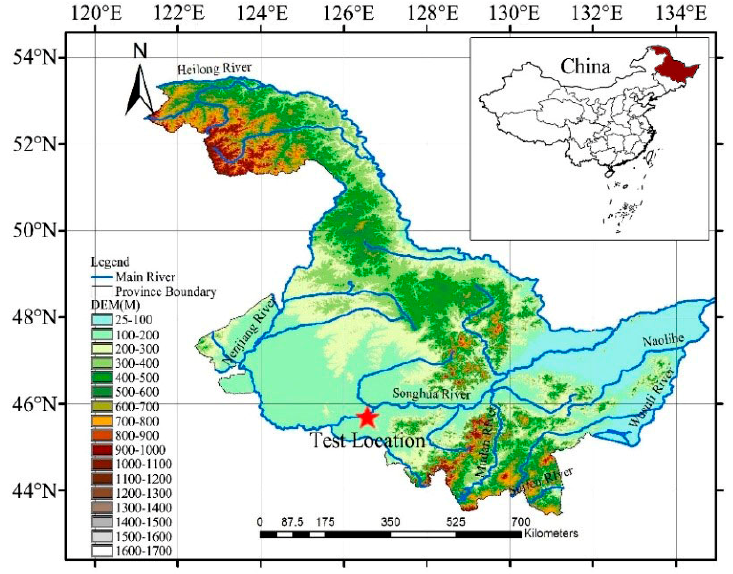
Figure 1. The area location map.